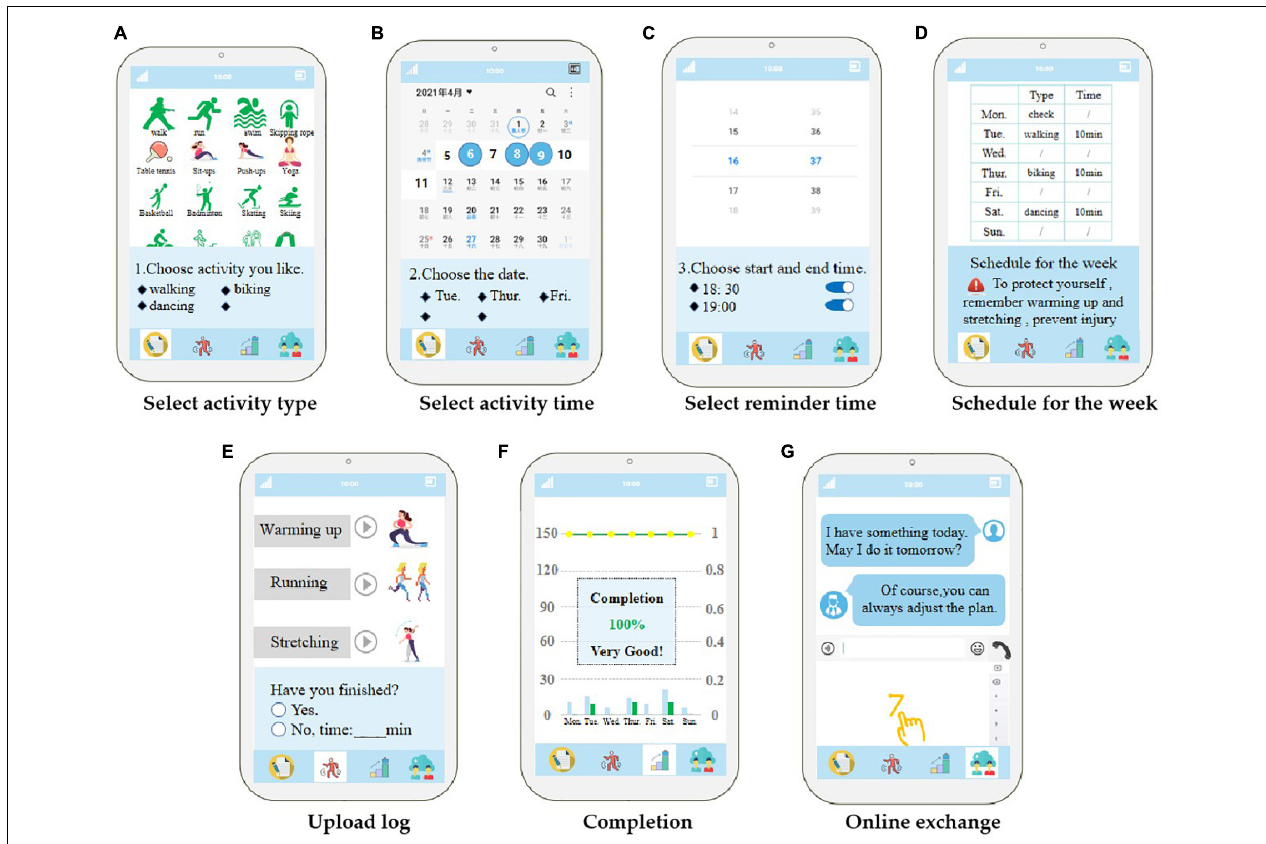
FIGURE 2 | Prototype of the app user